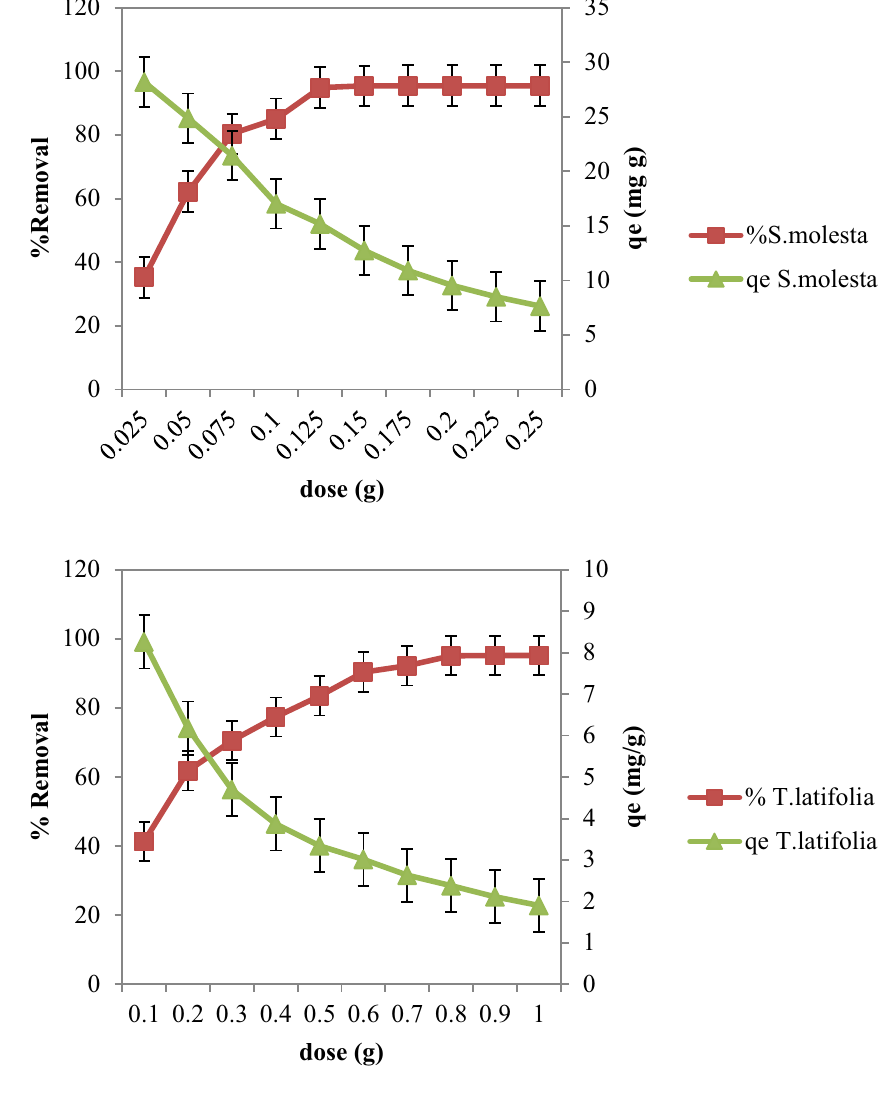
Fig. 4 Effect of adsorbent dose on Cr 6+ adsorption by S. molesta